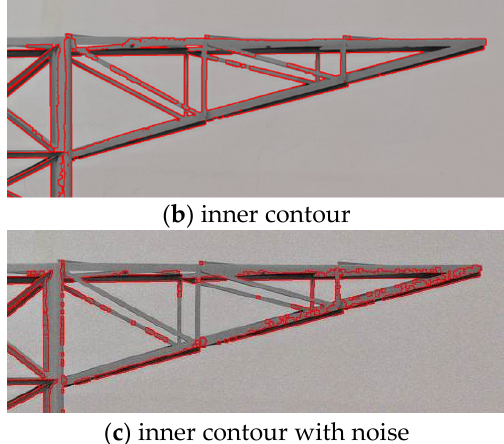
Figure 6. Results of inner contour identification under uneven lighting.